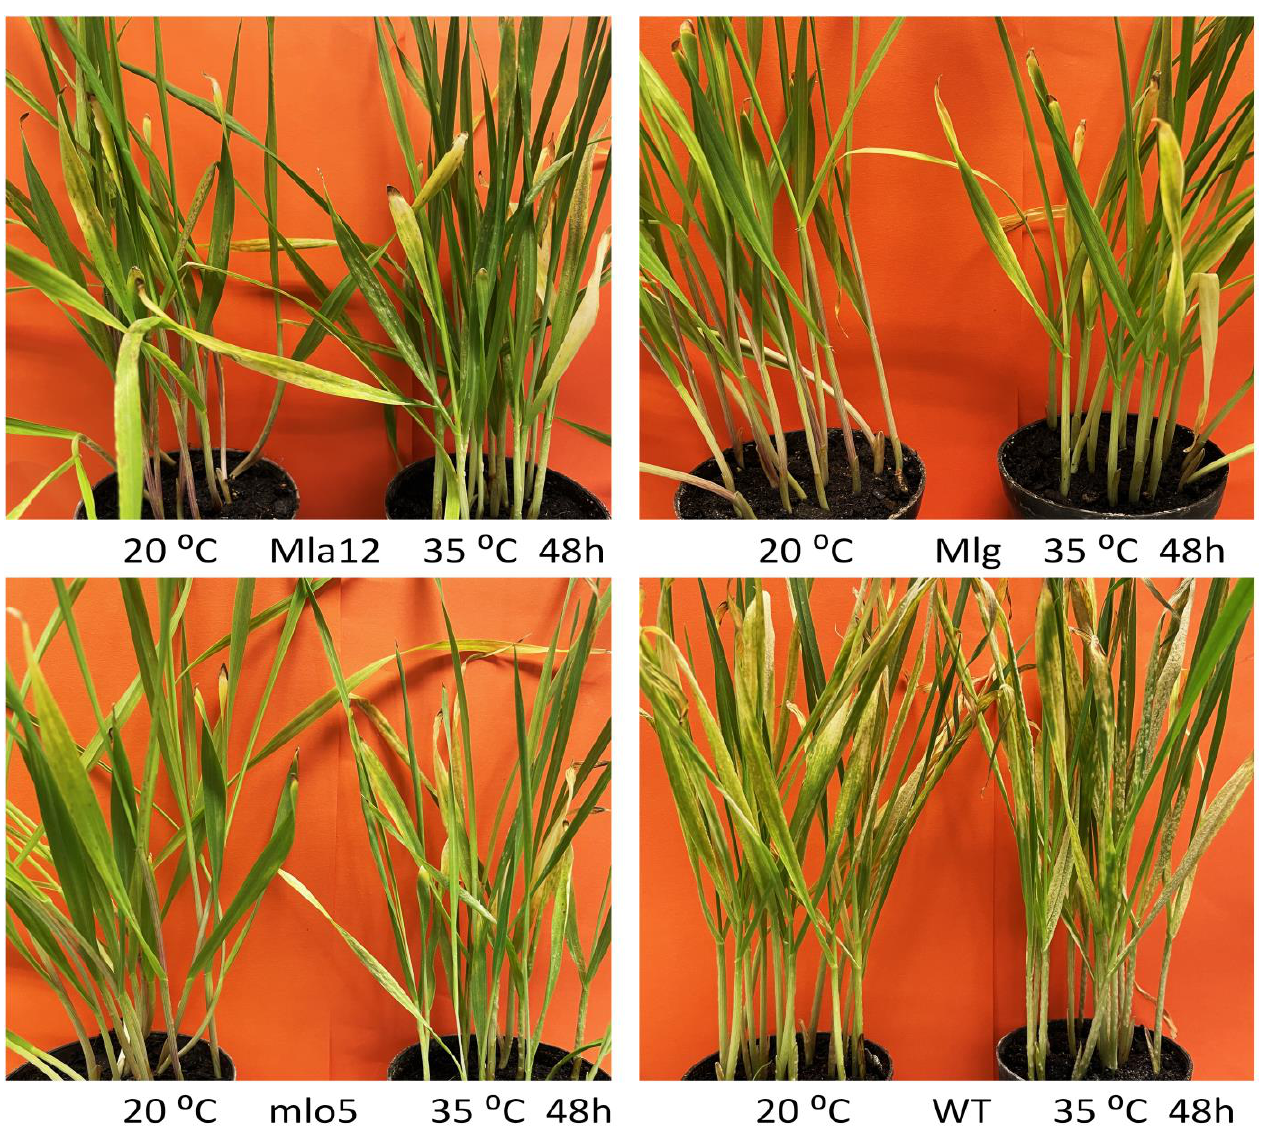
Figure 2. Powdery mildew ( Blumeria graminis f. sp. hordei A6) symptoms in resistant (Mla12, Mlg, mlo5) and susceptible (WT) near-isogenic lines of Hordeum vulgare cv. Ingrid seven days after inoculation. Barley plants were exposed to high-temperature stresses at 35 °C for 48 h (h) before powdery mildew inoculation. Control plants were kept at 20 °C.